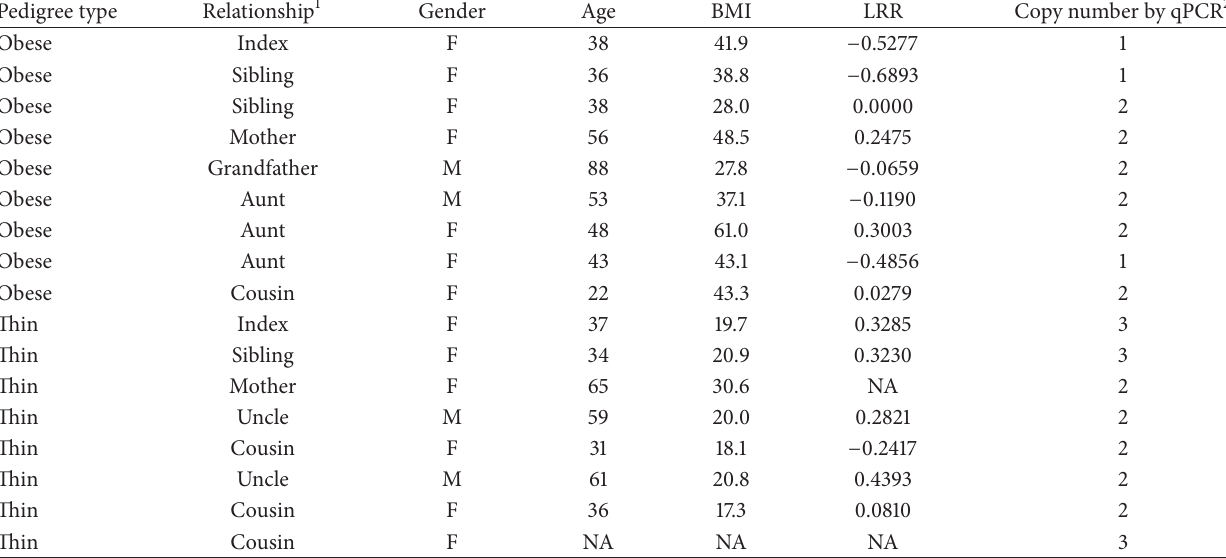
Table 4: Copy number of SLC2A4RG on chromosome 20 measured by qPCR on selected members of one thin and one obese pedigree. Replicate qPCR measurements on four individuals fell within 3% of the original measurement and qPCR on a local pooled female sample exhibited 2